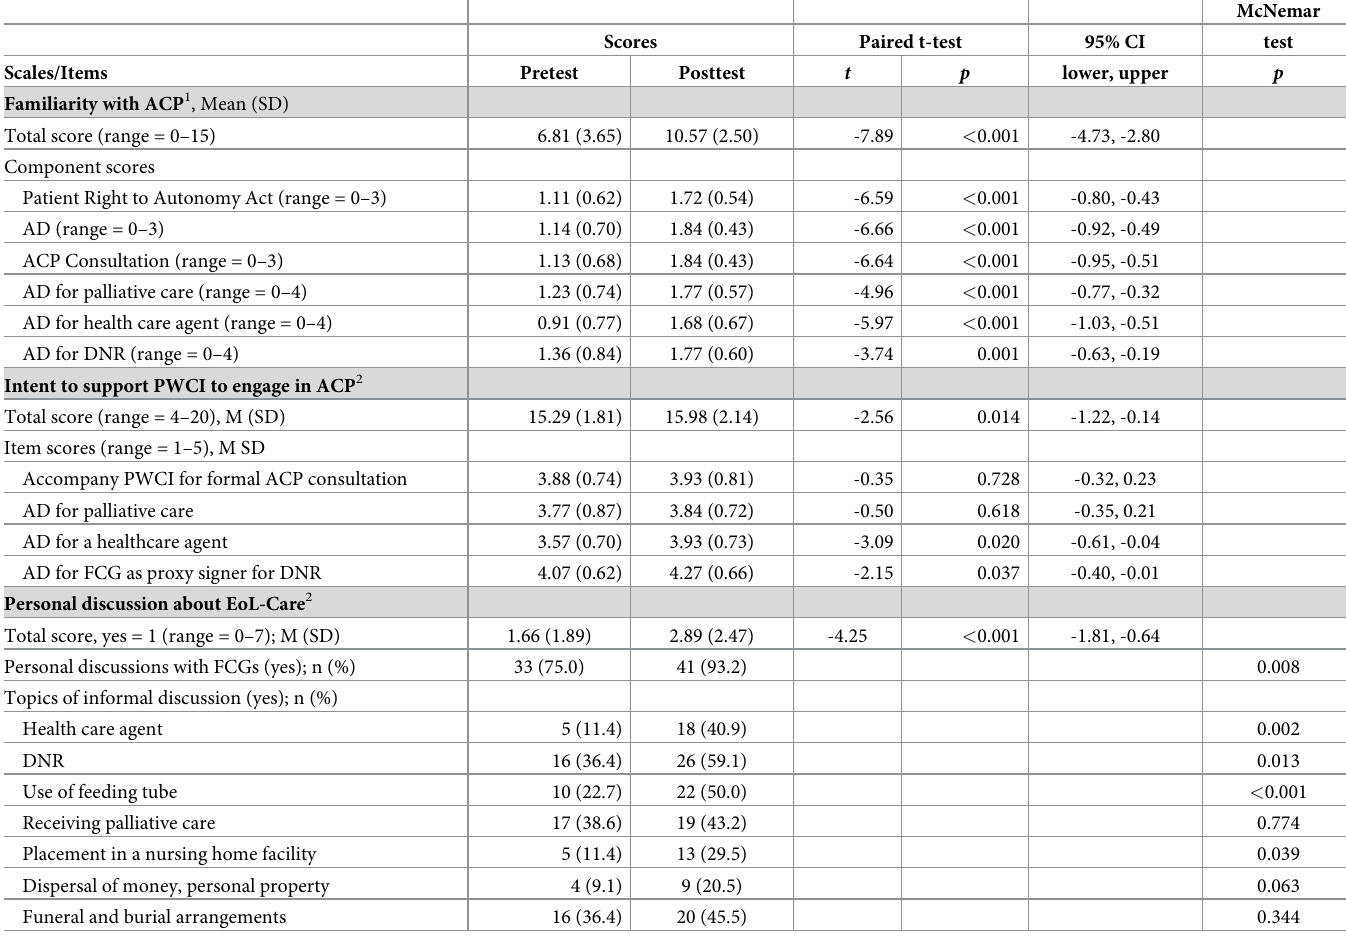
Table 5. Scale scores for FCGs (n = 44): Familiarity with ACP, intent to engage in ACP, and participation in personal discussions about EoL-care and ACP pre- intervention (pretest) and post-intervention